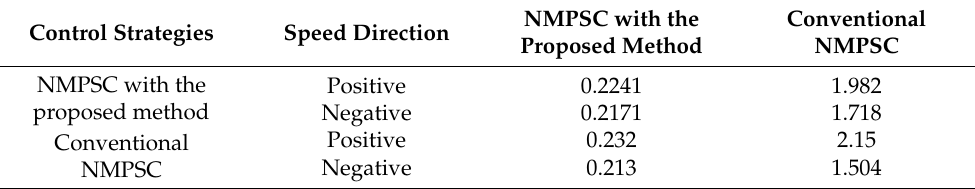
Table 3. Ramp reference performance comparisons within 0.8 s.